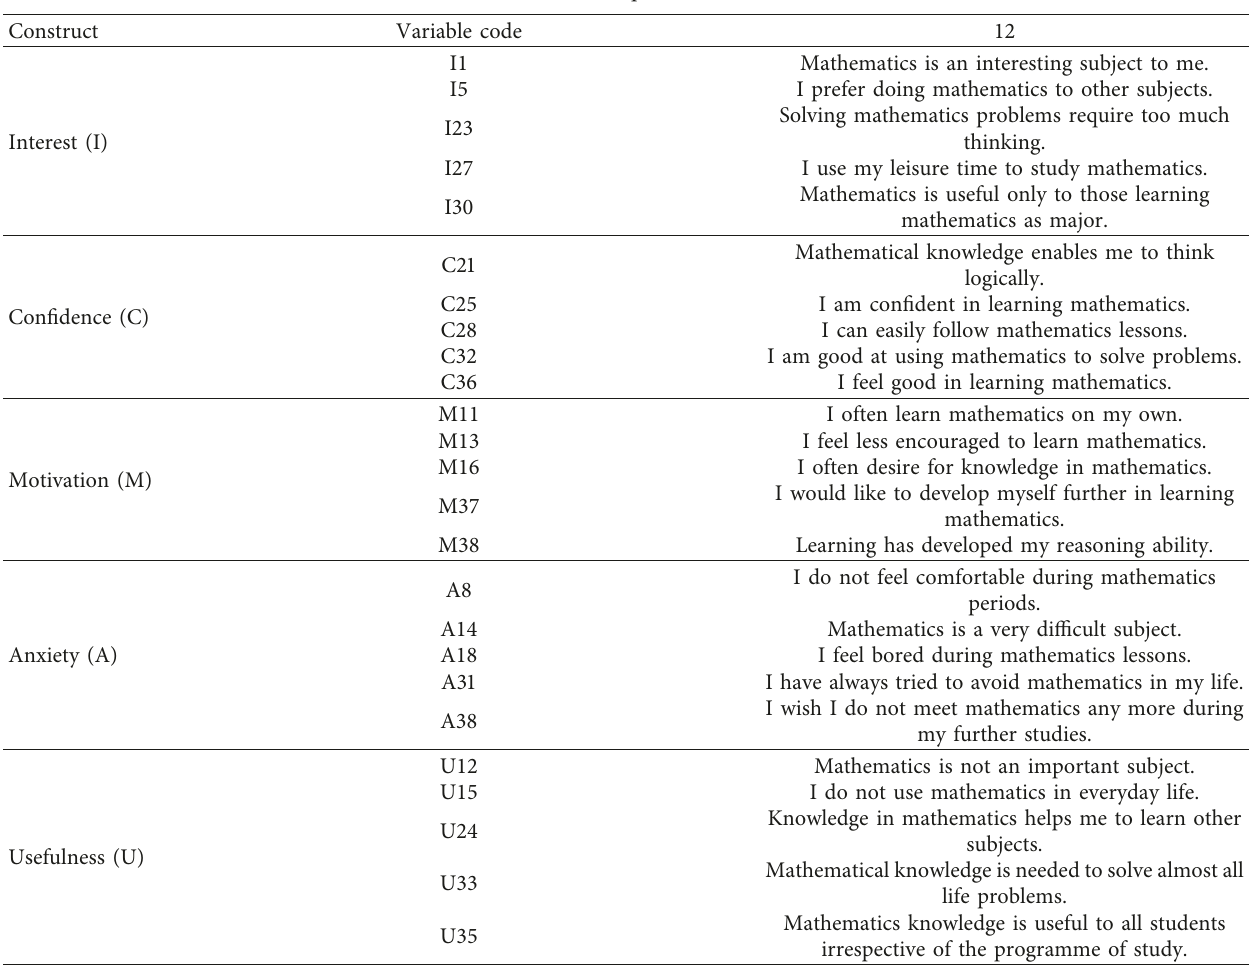
Table 1: Codes for questionnaire items.